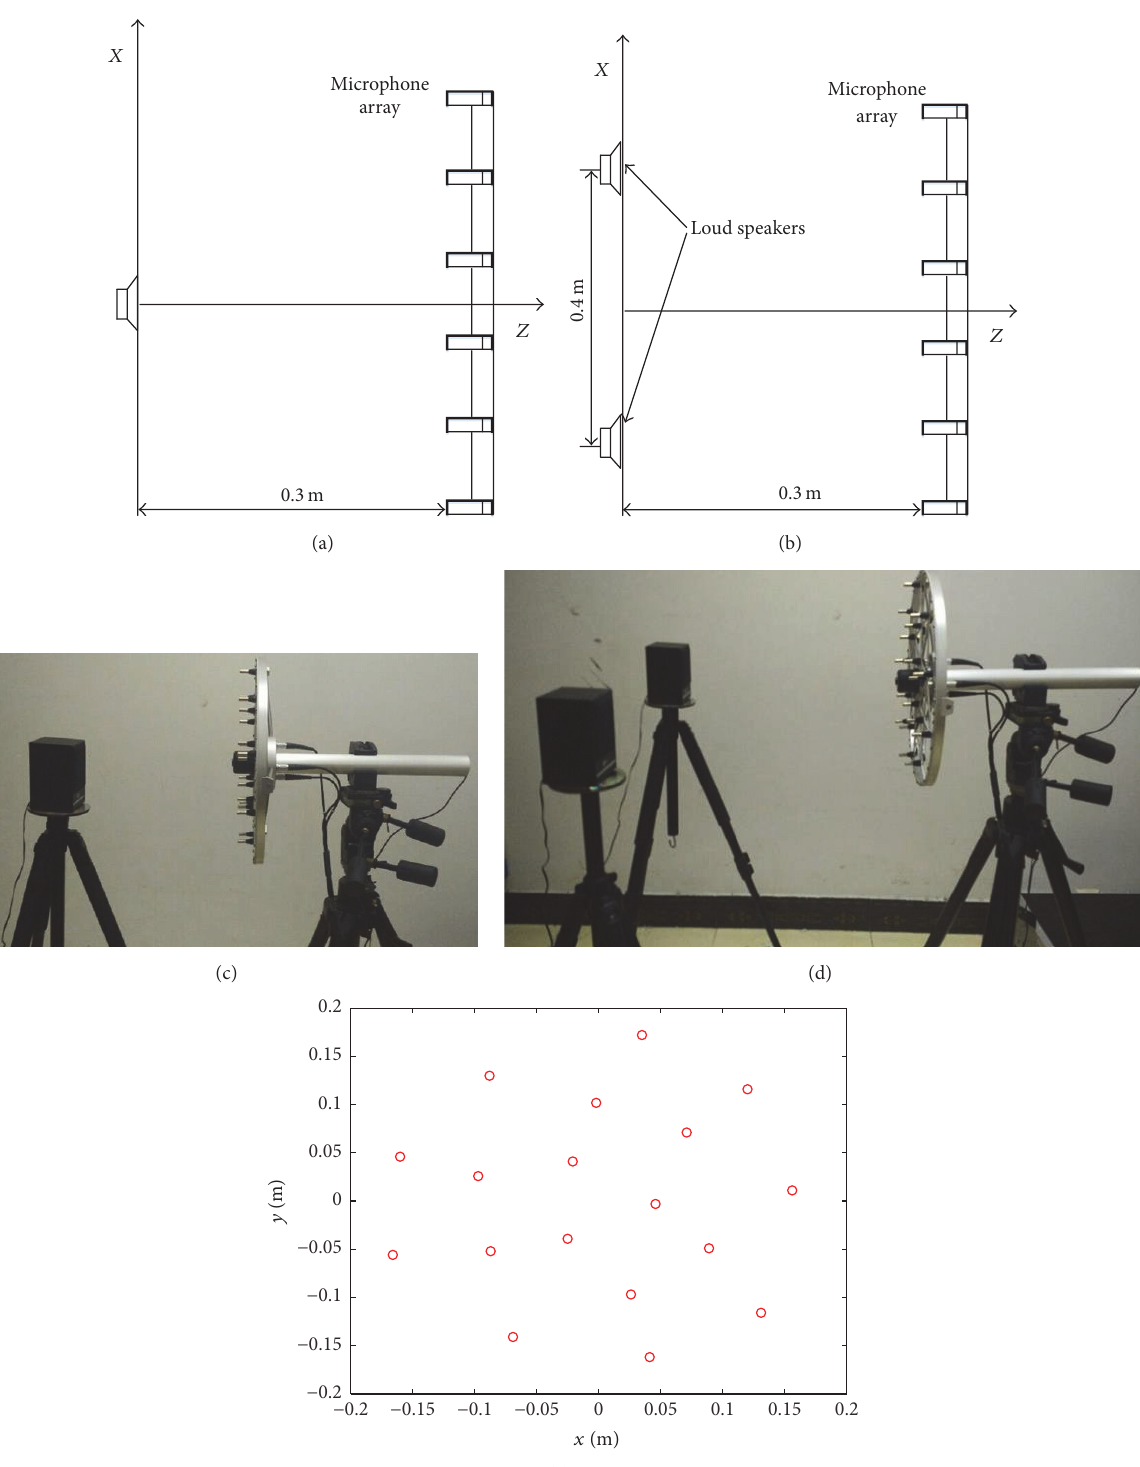
Figure 9: Experimental setup: (a), (c) single noise source; (b), (d) two noise sources; (e) microphone array